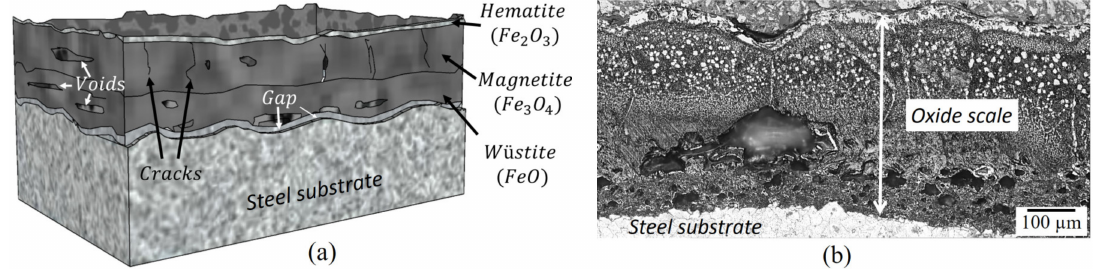
Figure 4. Schematic representation of phases formed in oxides on steel: ( a ) hematite, magnetite, and wüstite phases; ( b ) oxide formed on a micro-alloyed